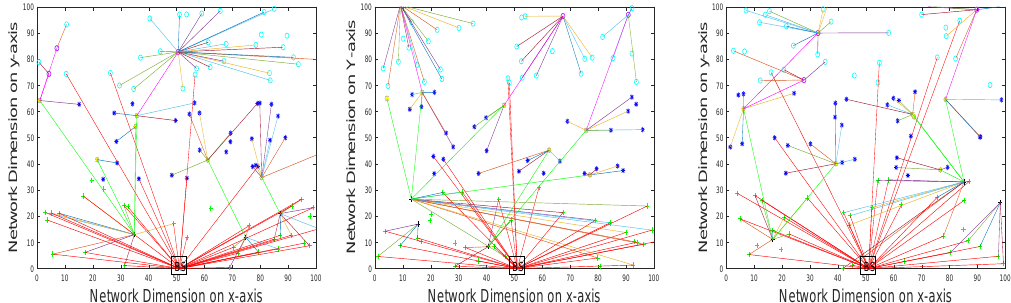
Figure 4. Iterative clustering topology in the case of the SAMCFIR routing protocol.